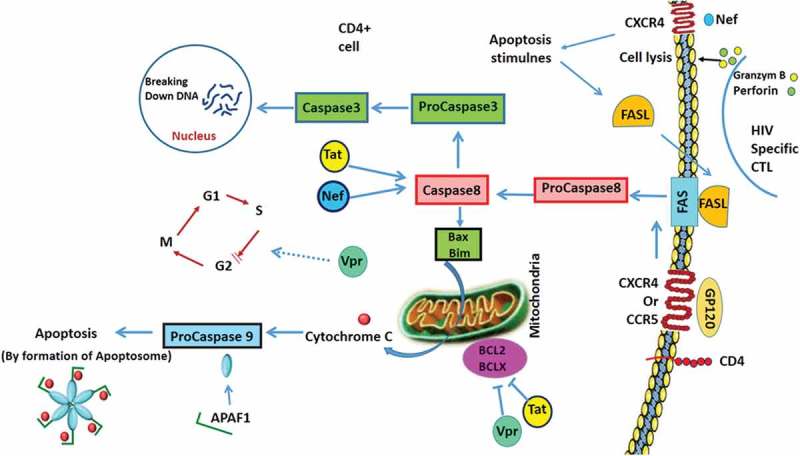
Apoptosis Signalling in T-Helper Cells During HIV Infection.HIV proteins are involved in apoptosis. GP120 attachment to CD4 receptor and CCR5 or CXCR4 can induce the extrinsic pathway in a Fas-dependent manner. GP120 induces Bax expression which activates the intrinsic pathway of apoptosis by the release of cytochrome C (Cyto c) and formation of the apoptosome. Vpr causes cell cycle arrest at the G2 stage. Tat and Nef activate the expression of caspase 8 which changes procaspase 3 to caspase 3 and results in DNA degradation. Tat and Vpr down regulate Bcl2 and BclXL.